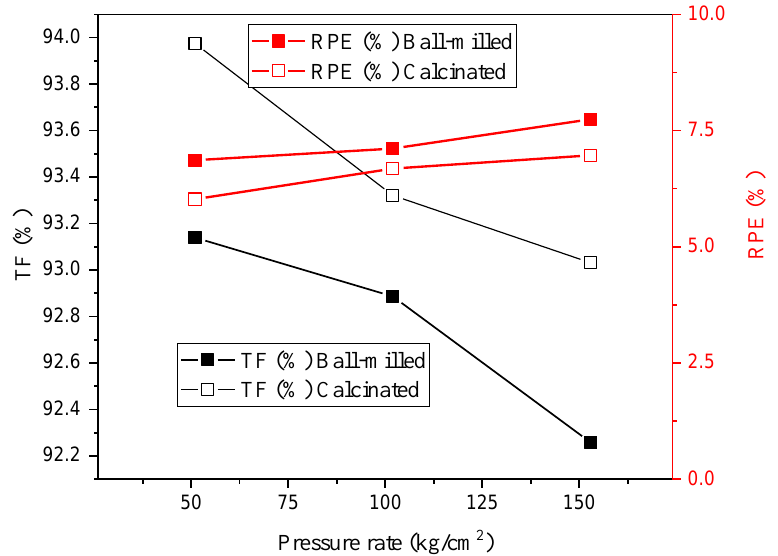
Figure 12. Variation in the TF and the RPE versus the pressure rate at 0.662 MeV.